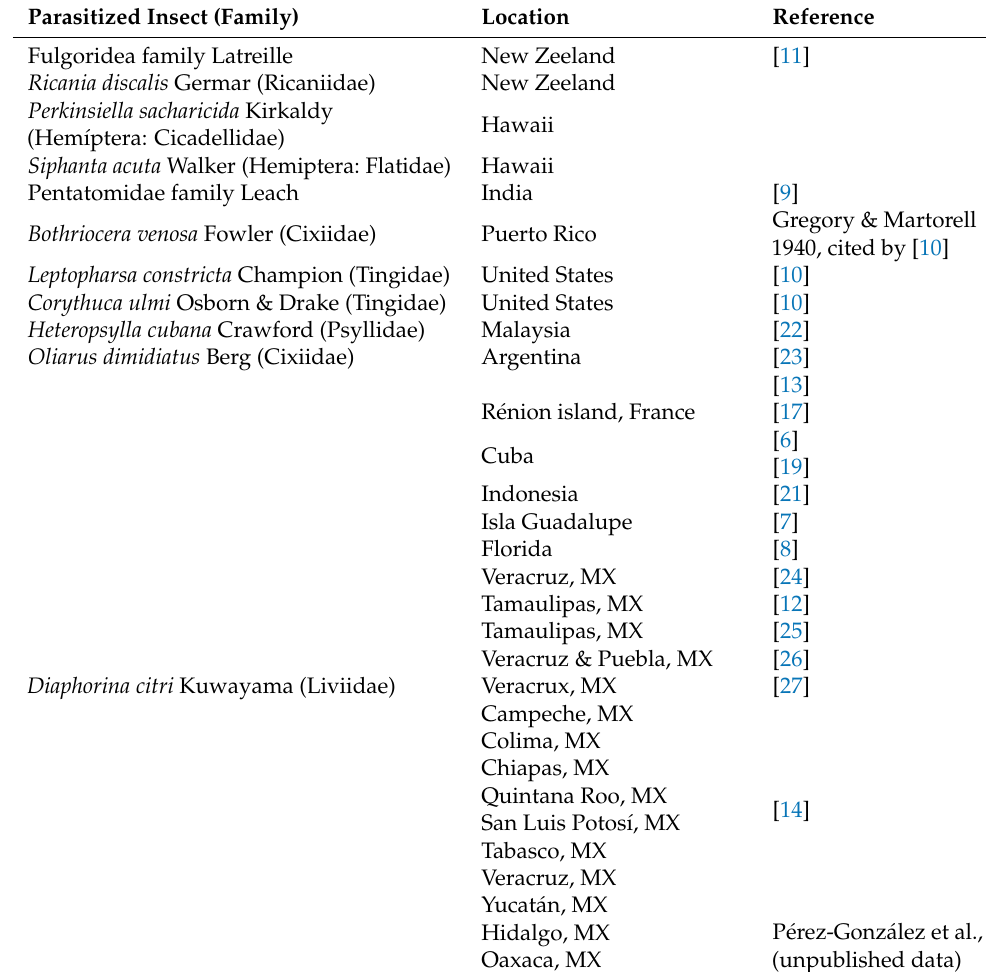
Table 3. Hirsutella citriformis isolation reports from different insects belonging to the Hemiptera order. Parasitized Insect